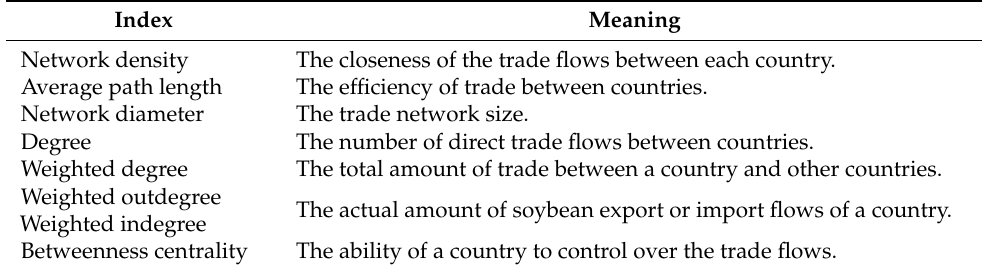
Table 1. Summary of the basic topological properties of complex